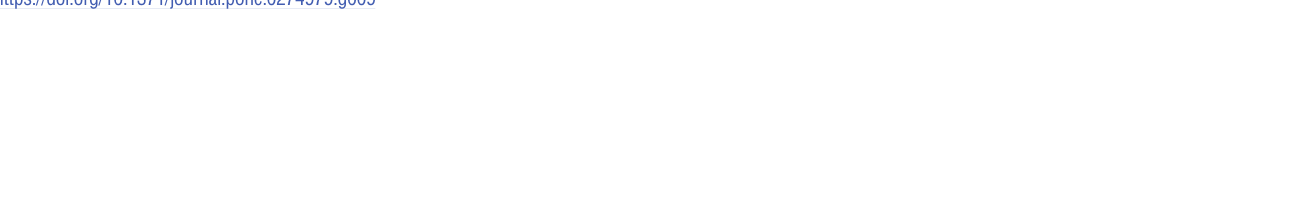
PLOS ONE | https://doi.org/10.1371/journal.pone.0274979 March 9, 2023 15 /